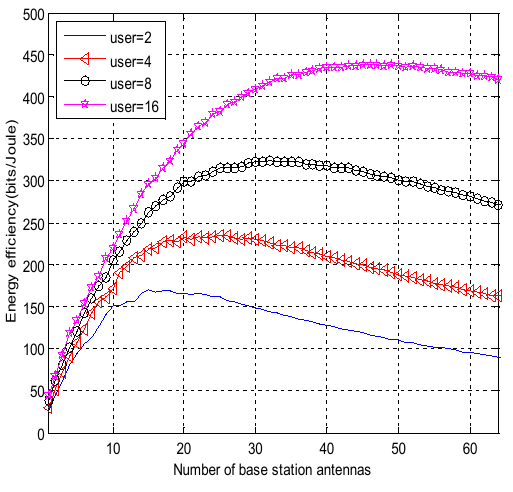
Figure 5. Energy efficiency of the iterative power allocation